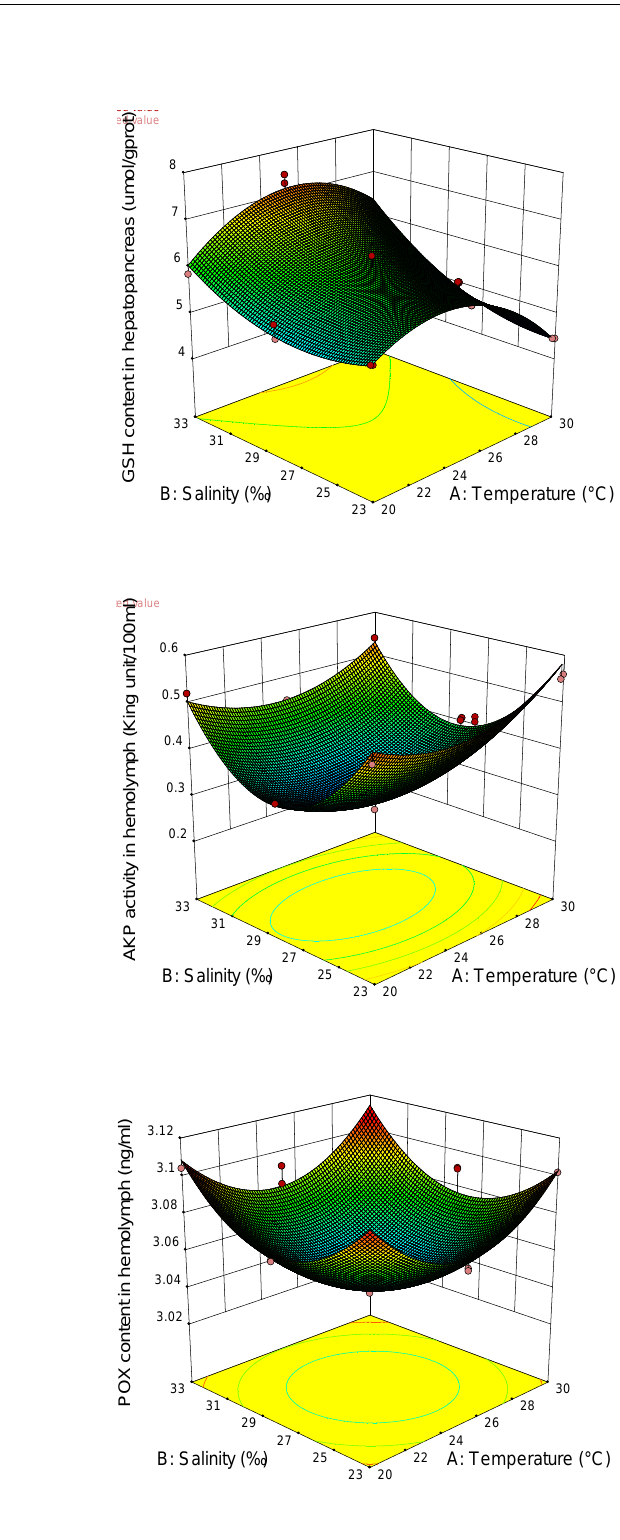
Figure 1. Response surface plots ( right ) and contour plots ( left ) of salinity and temperature to antioxidant and immune-related (non-) enzyme activities (contents) of the pearl oyster. The activities (contents) of AKP, GSH-PX, MDA, SOD, CAT, GSH, AKP (hemolymph), and POX are shown from top to bottom.